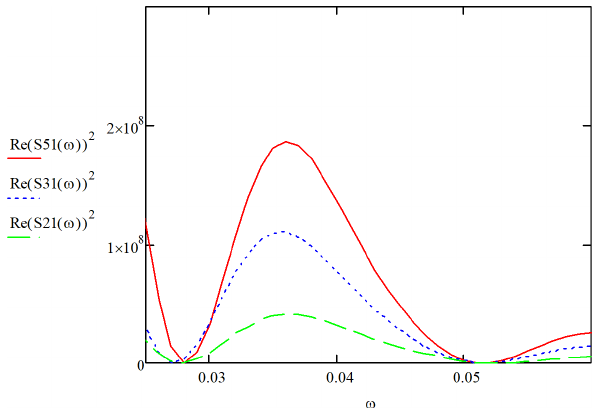
Figure 6. The square of the amplitude of the real part of the spectral characteristic of the sensor, proportional to the concentration of the measured component in the gas mixture.